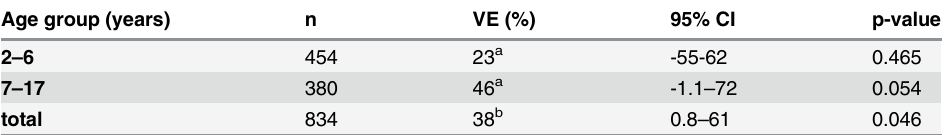
Table 4. Vaccine effectiveness of all seasonal vaccines against laboratory-confirmed influenza of all subtypes, stratified by age groups; Multivariable logistic regression, Virological Surveillance, Saxo- ny-Anhalt, Germany 2012/13 (n = 834).